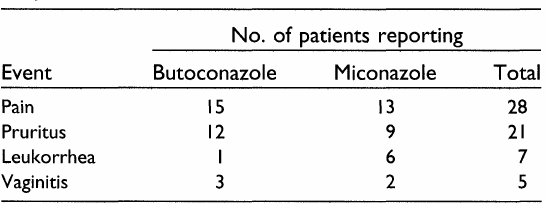
TABLE 3. Urogenital adverse events reported by >3